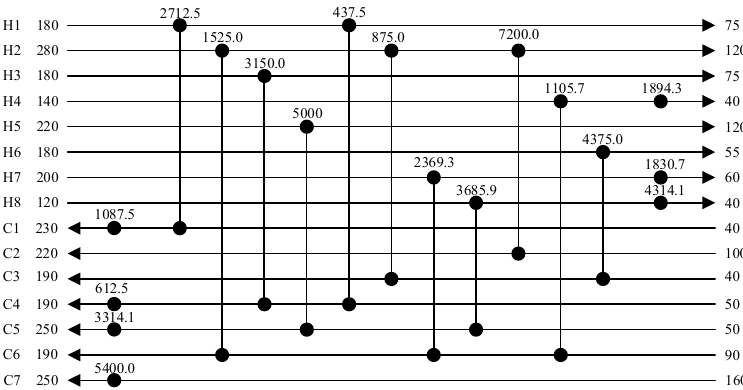
Figure 16. RWCE optimization results using the weighted evolution strategy.